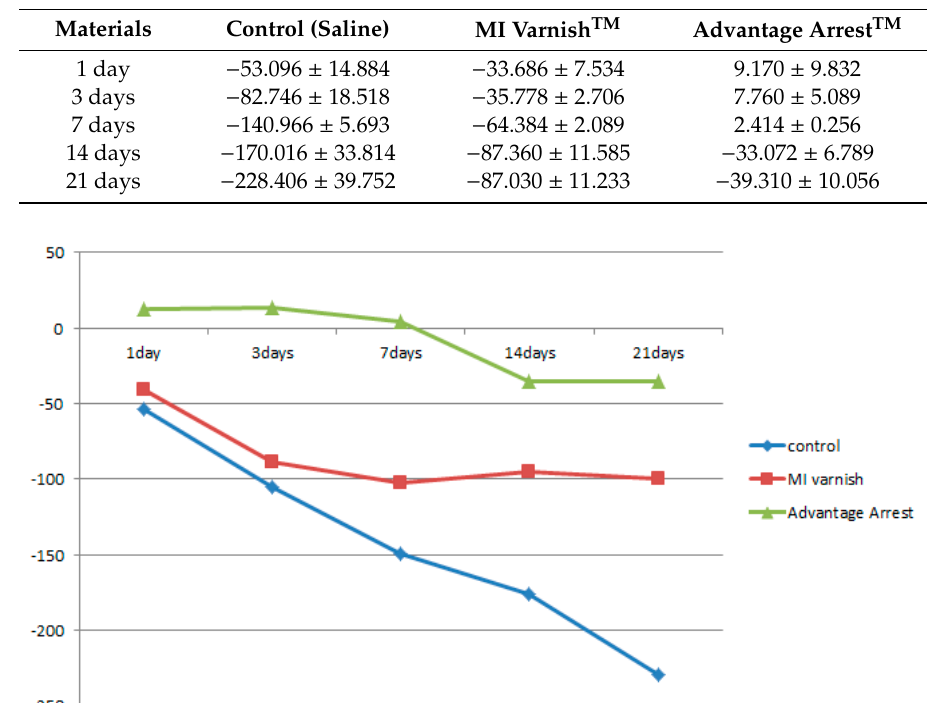
Figure 8. Comparison of the change in mean enamel Hounsfield unit value at a depth of 40–60 µ m between groups at each time point.